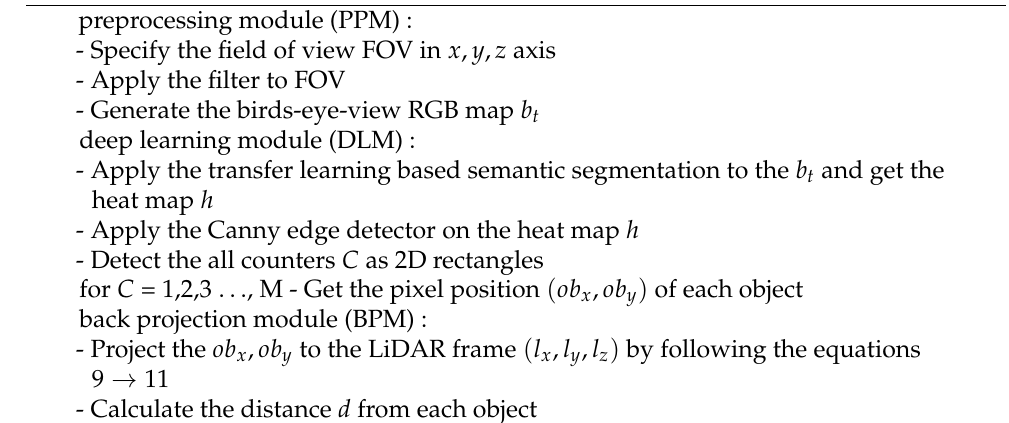
Algorithm 1 Transfer learning based semantic segmentation for 3D object detection.